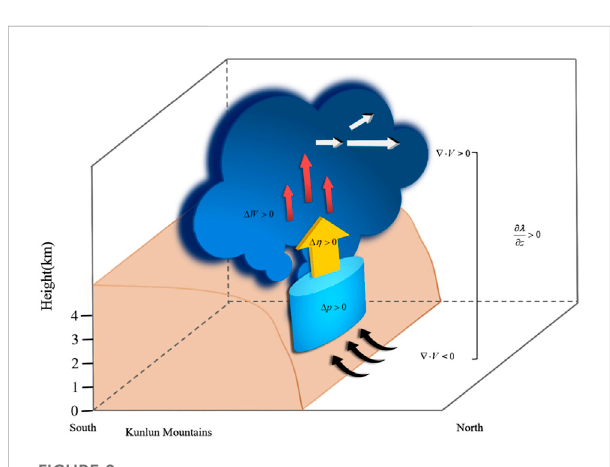
FIGURE 9 Schematic of convection initiation in southern